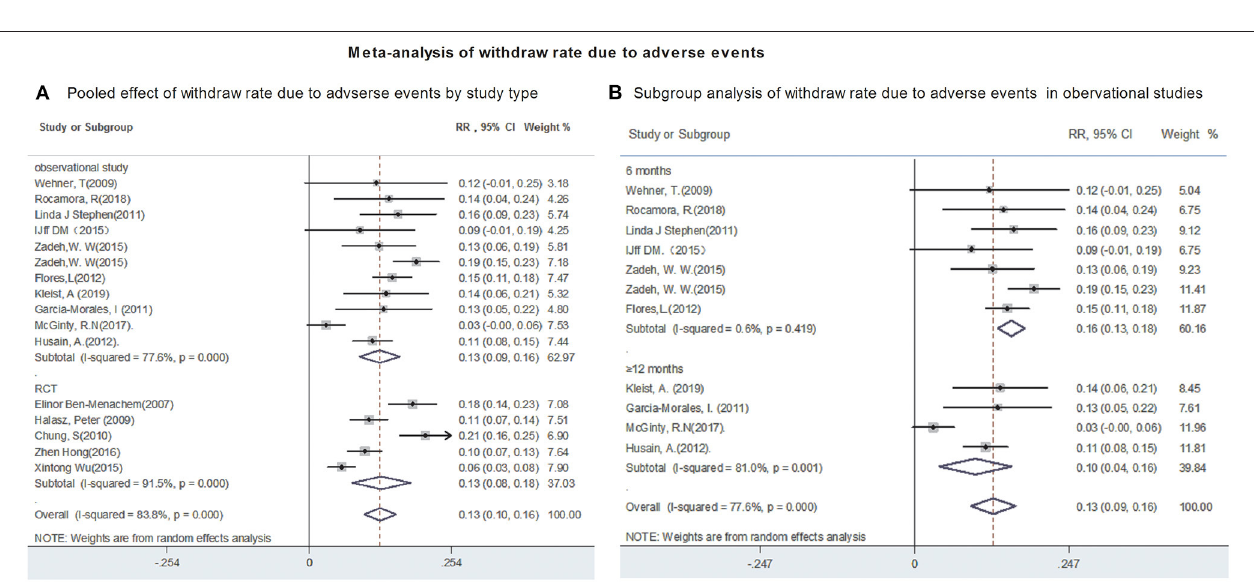
FIGURE 5 | Meta-analysis of withdraw rate due to adverse events. (A) Poole effect of withdraw rate due to adverse effects by study type. (B) Subgroup analysis of withdraw rate due to adverse effects in observational studies.